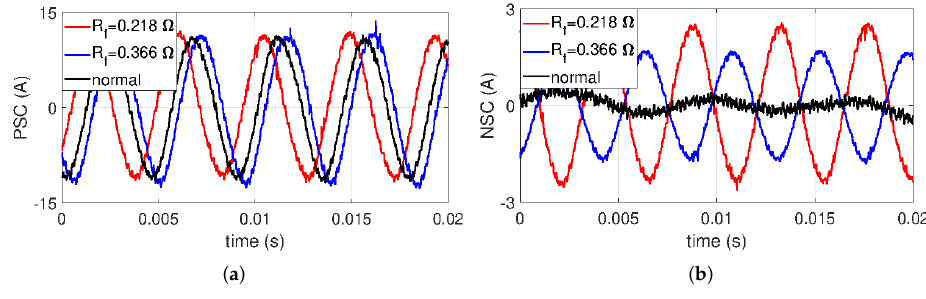
Figure 9. ( a ) PSC and ( b ) NSC with R f at rated conditions.